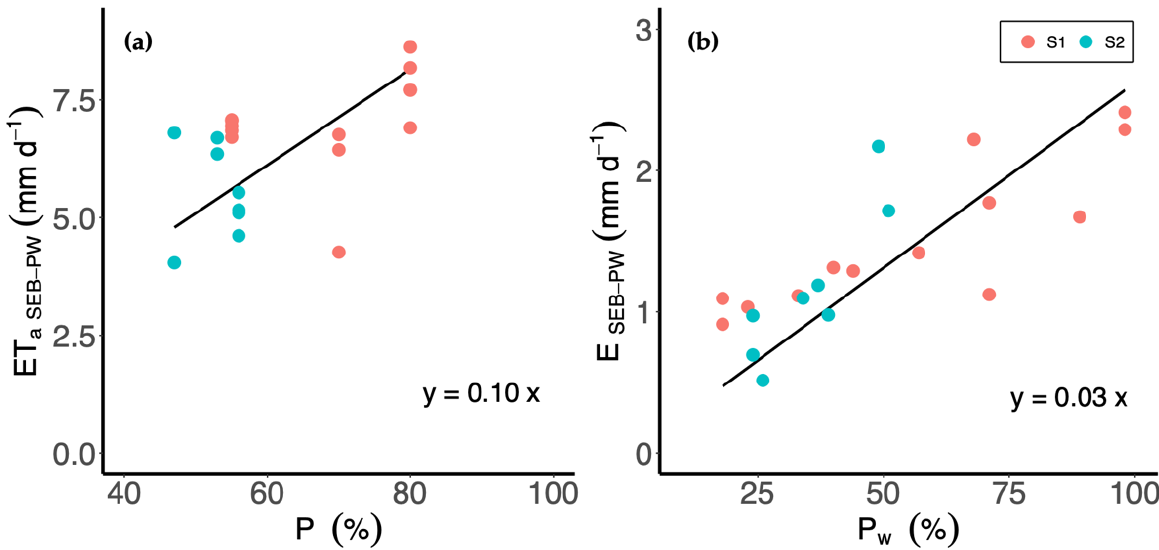
Figure 12. Relationship between actual ET (ETa) and E estimated by the SEB – PW model and the fraction of soil shaded by the plant canopy at solar noon (P) ( a ) and the wet soil fraction (Pw) ( b ), respectively.